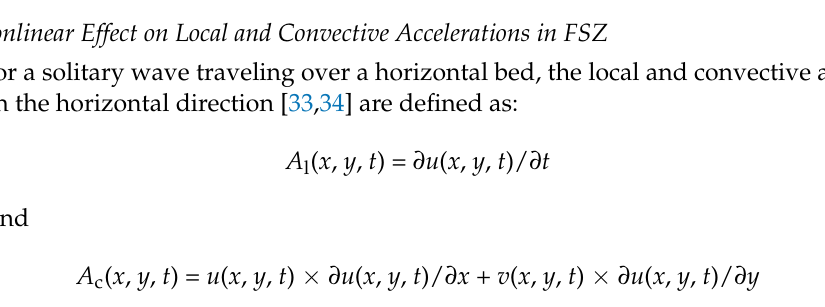
Figure 14. The relationship between [ u o ( T )/ C 0 ] mean and H 0 / h 0 for − 14.0 ≤ T ≤ 14.0.